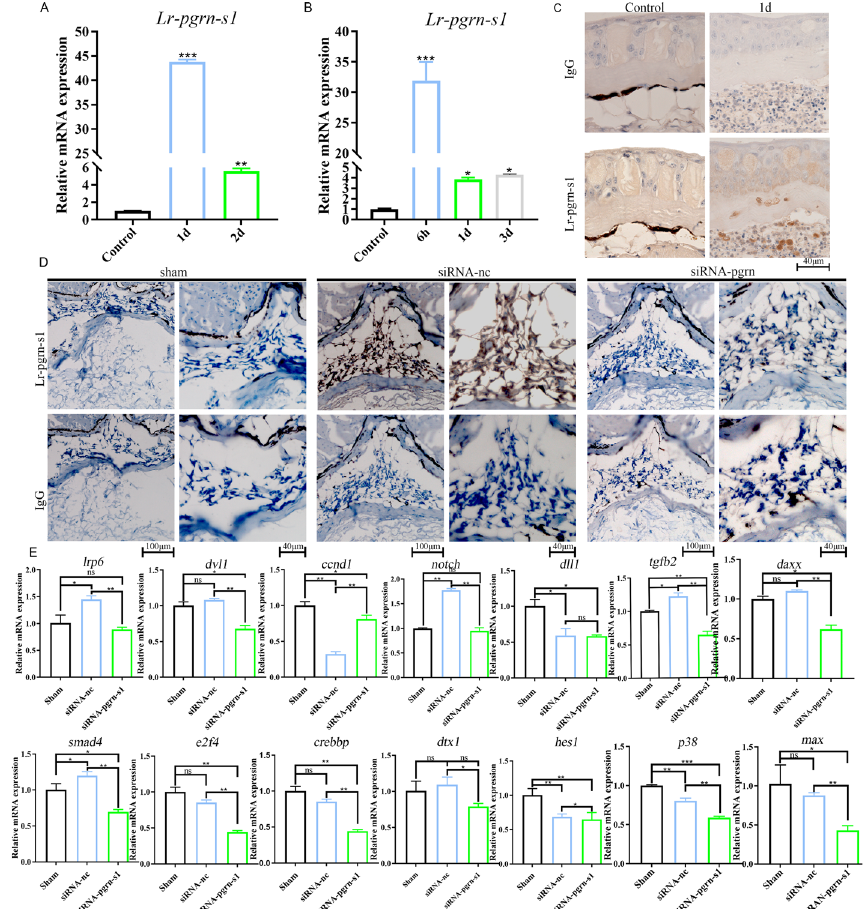
Fig. 5 Expression of Lr-pgrn-s1 after lamprey skin and spinal cord injury. A Expression of Lr-pgrn-s1 in lamprey skin lesions 1 and 2 days after injury. B Expression of Lr-pgrn-s1 in lamprey 6 h, 1 day, and 3 days after spinal cord injury by qRT-PCR. C Tissue-wise localization of Lr-PGRN-S1 1d after skin injury by immunohistochemistry. Pictures taken at 40 magnification. D Immunohistochemistry analysis shows × Lr-pgrn-s1 was knocked down 6 h after lamprey spinal cord injury. Results under 20 and 40 microscopy × × in sham, NC (normal control), and Lr-PGRN-S1 groups. E qRT-PCR analysis of genes in MAPK, Notch, Wnt, and TGF-β signaling pathways. Statistical differences between experimental groups were detected by Student’s t test. All data presented as mean SD based on three independent samples with three replicates per sample. ± ns nonsignificant, * P < 0.05, ** P < 0.001, *** P <